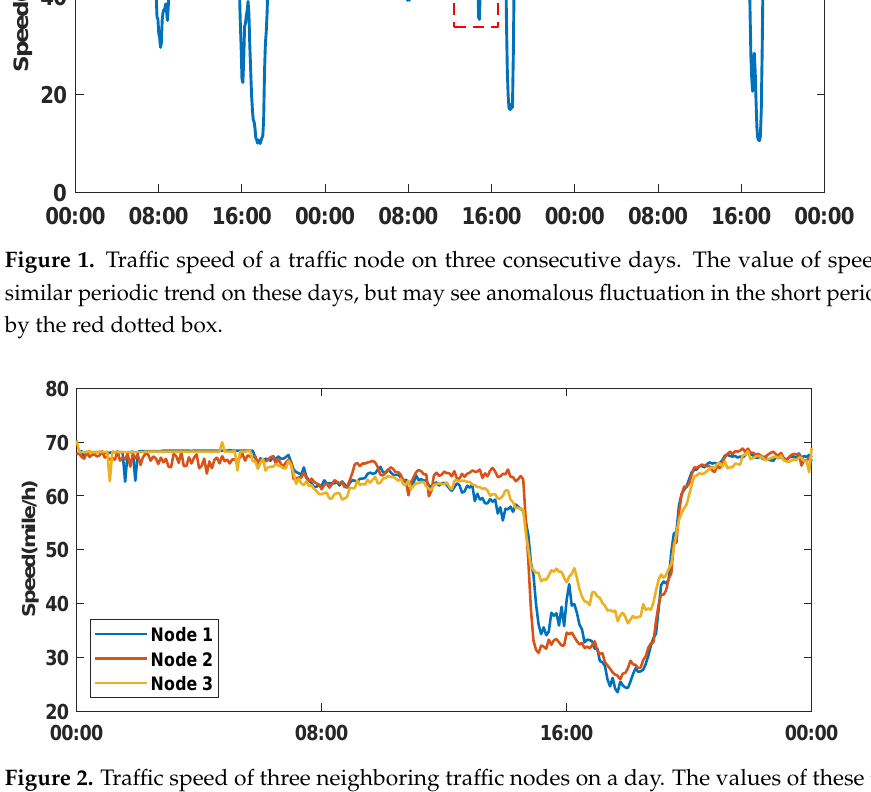
Figure 2. Traffic speed of three neighboring traffic nodes on a day. The values of these three nodes show strong